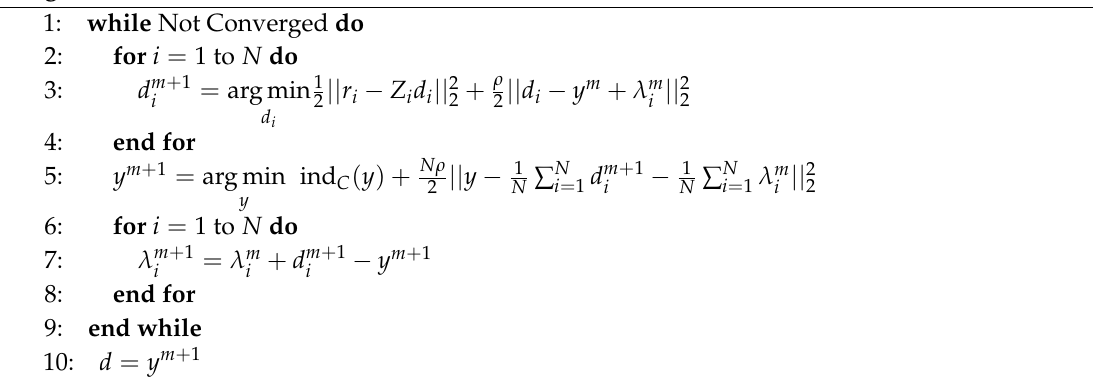
Algorithm 2: CSC Reflectance function ADMM for the Filters d